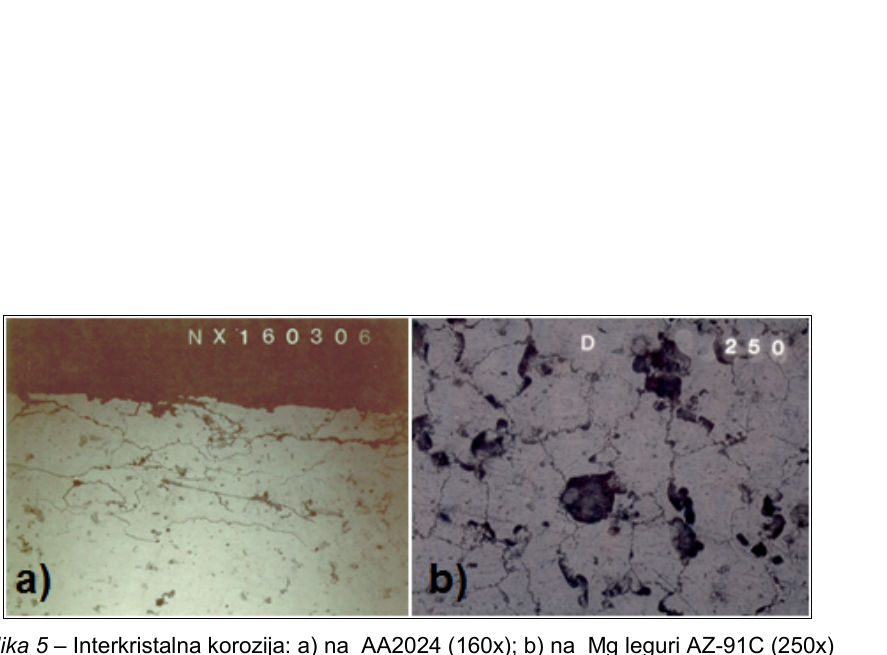
Figure 5 – Intergranular corrosion: a) on AA2024 (160x); b) on Mg alloy AZ-91C (250x)